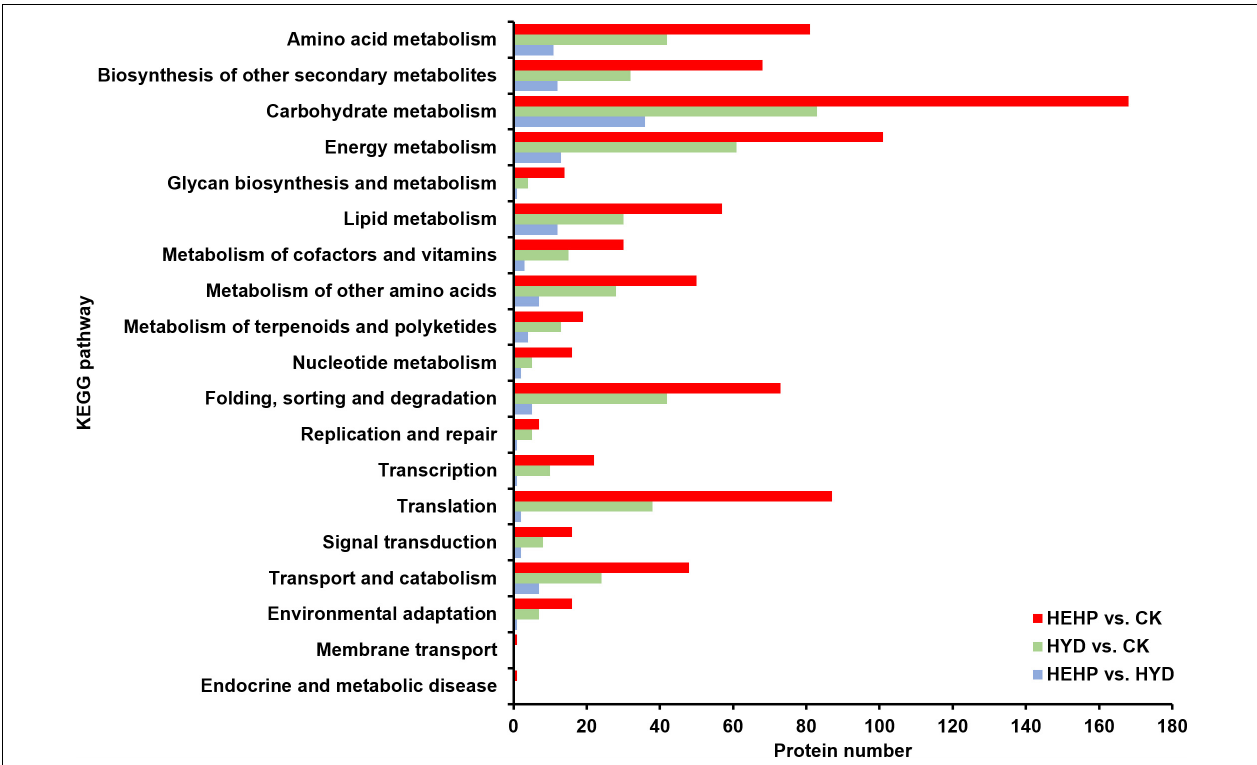
FIGURE 5 | Kyoto Encyclopedia of Genes and Genomes (KEGG) annotation of DAPs in HEHP vs. CK, HYD vs. CK and HEHP vs. HYD.